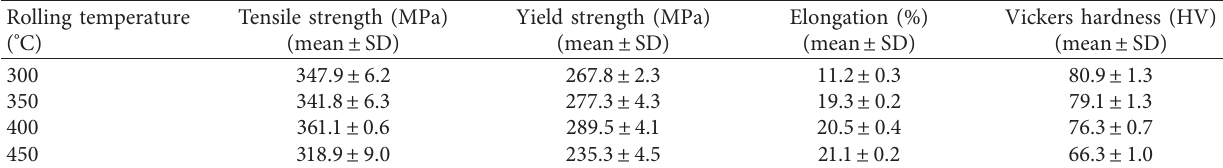
Figure 13: The tensile stress-strain curves of the alloys rolled at different temperatures (a), the changes of tensile mechanical properties (b), and Vickers hardness (c) of the alloys with rolling temperatures. Table 2: Mechanical properties of alloy rolled at different